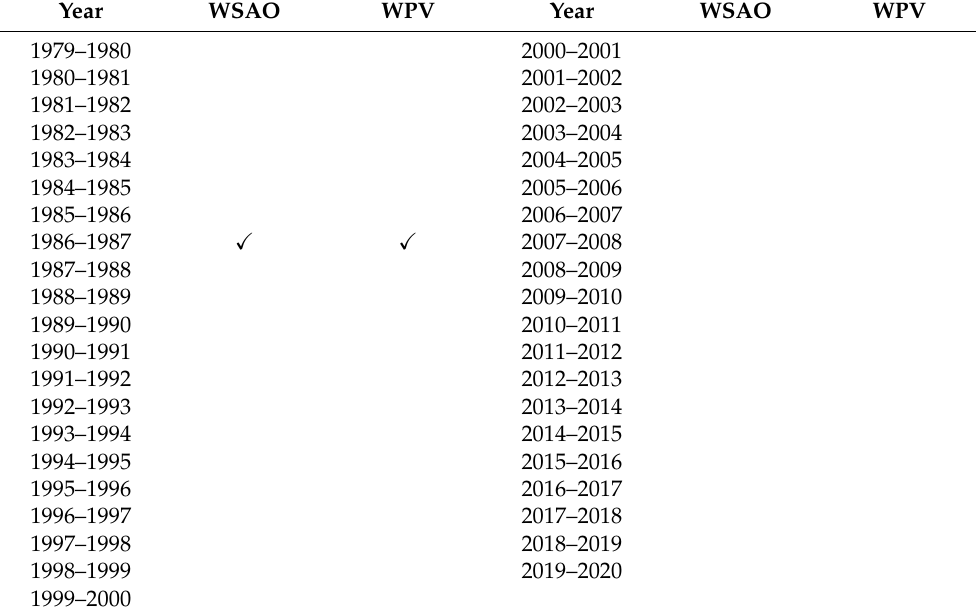
Table 2. Simultaneous occurrence of the westerly phase of the SAO (WSAO) and weakened polar vortex (WPV) in winter from 1979 to 2020.